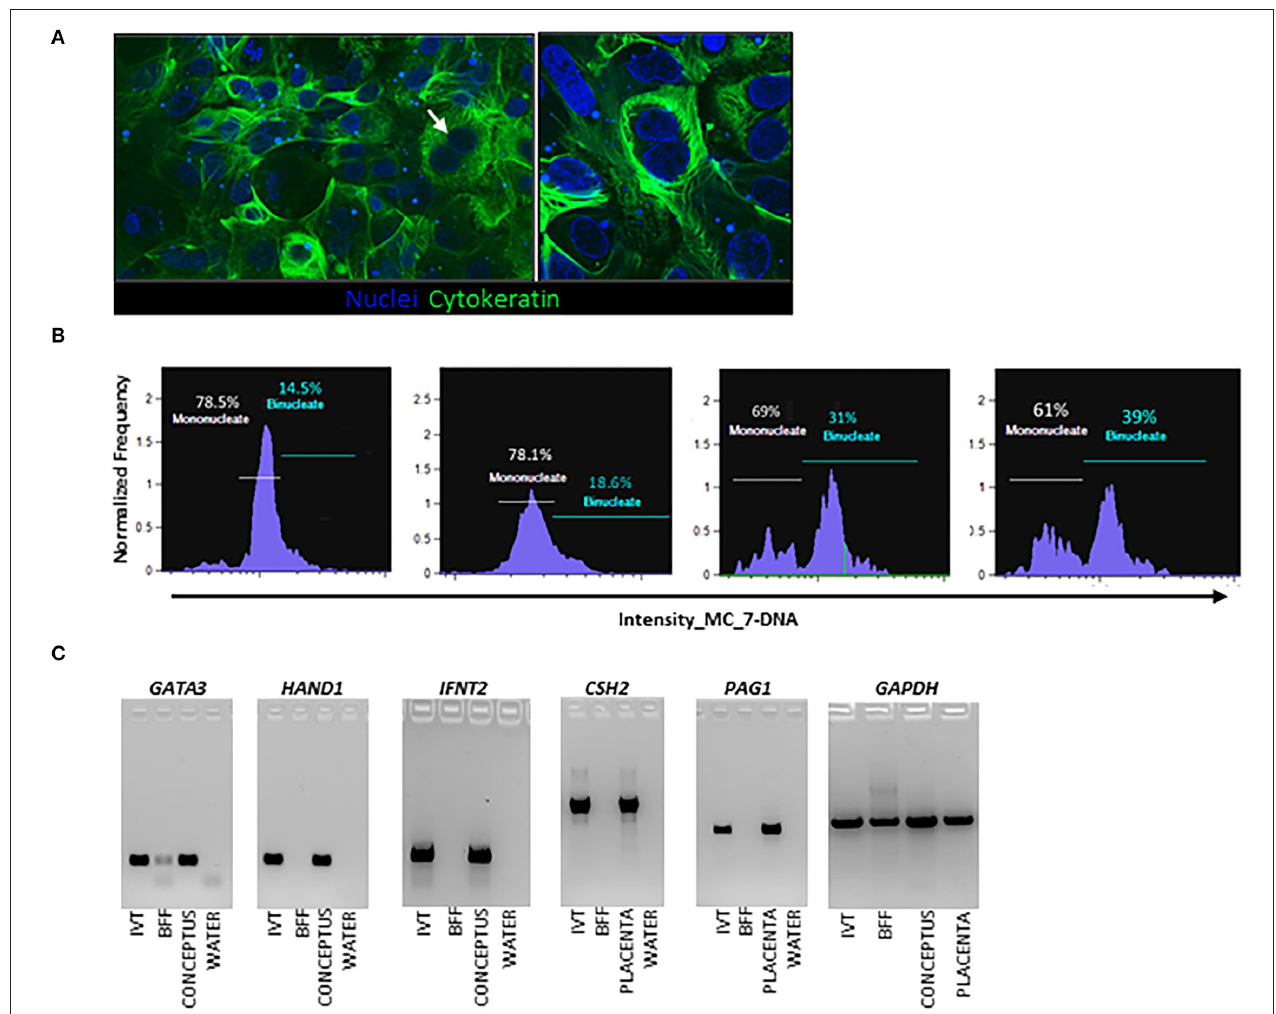
FIGURE 2 | Characterization of in vitro derived trophectoderm (IVT) cells from bovine embryo outgrowths. (A) Cytokeratin analysis in day 30 embryo outgrowth cultures. Cytokeratin is green with nuclei-stained blue using Hoechst dye, a total of three samples were analyzed. (B) Flow cytometry analysis, a total of four independent samples were analyzed. (C) Endpoint PCR analysis. IVT are embryo outgrowths on day 30 of culture (pool of three different embryo outgrowths). Positive controls are a day 20 conceptus and day 30 bovine placenta. Negative controls are bovine fibroblasts (BFF), and reaction control was